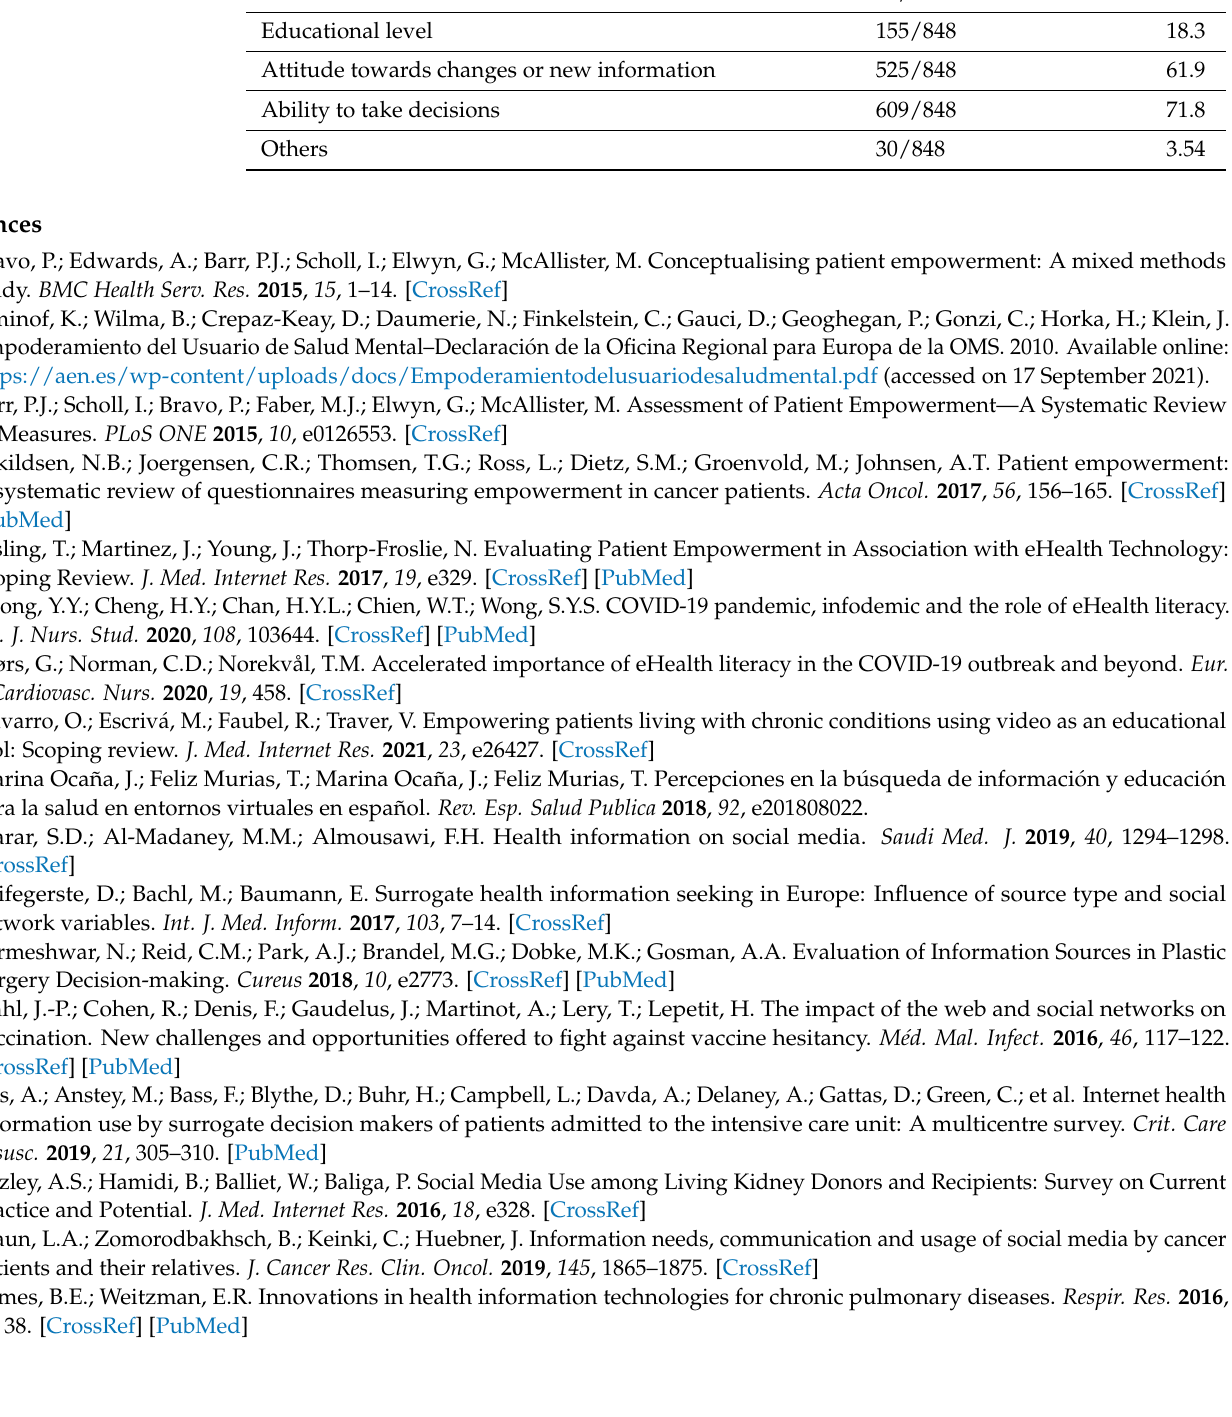
Table A2. Cont. Attitude towards changes or new information Ability to take decisions, Others Attitude towards changes or new information Educational level Others (b) Assuming separate variables, for each method, how many people use it: How do nurses estimate the empowerment of their patients?